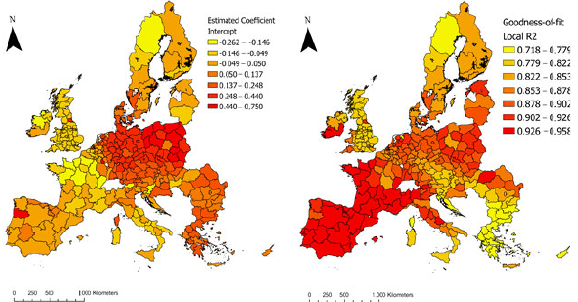
Figure 6. Spatial distribution of the intercept parameter and local R 2 estimates in the MGWR model. Source: authors’ own work.